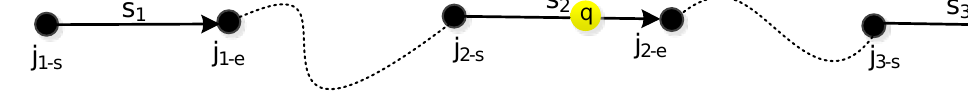
Figure 4. Distance edge.